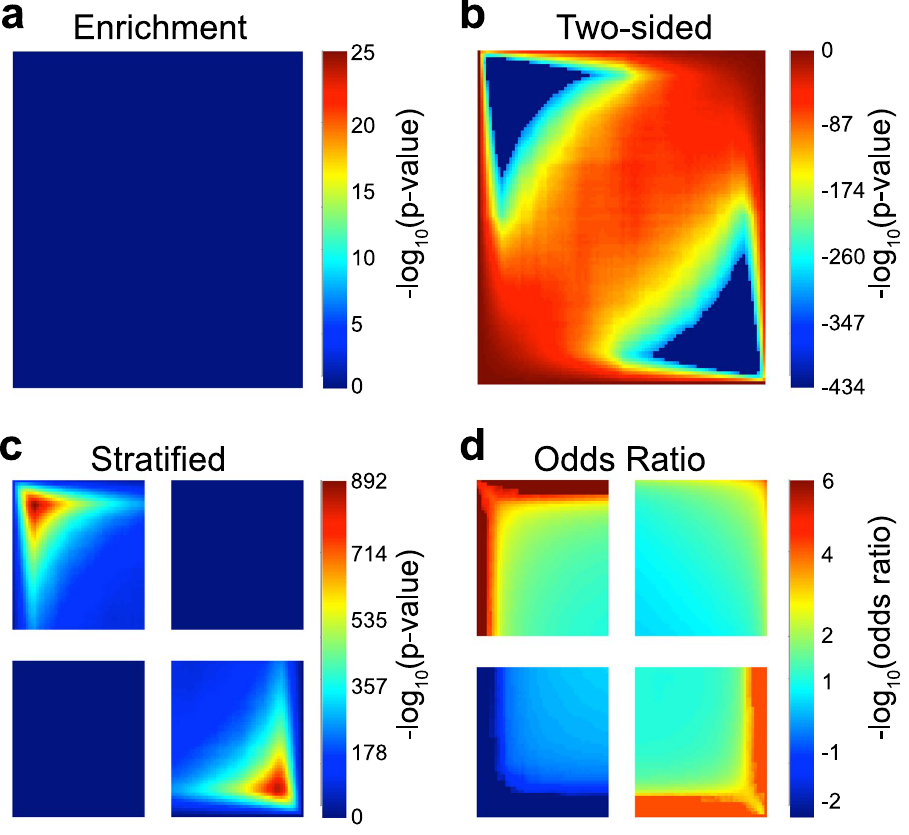
Figure 5. Heatmaps from simulation 2, with the two studies showing opposite effect size directions. RRHO plots are shown using ( a ) Enrichment, ( b ) Two-Sided, ( c ) Stratified, and ( d ) Log Odds Ratio RRHO